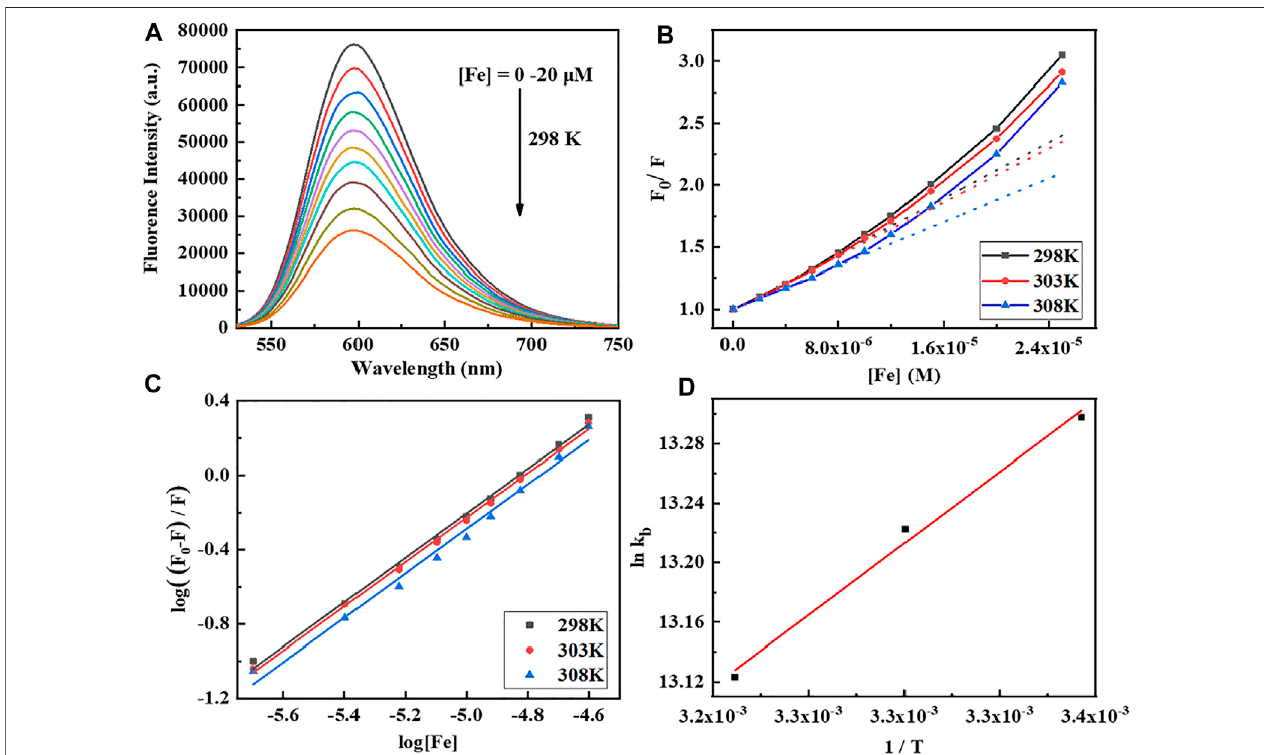
FIGURE 1 | (A) Fluorescence emission spectra of CT-DNA (170 μ M) titration with the Fe complex by increasing concentrations (0 – 20 μ M). The excitation wavelength is 520 nm at pH 7.4 and 298 K. (B,C) Stern – Volmer plot of CT-DNA quenched by the Fe complex at different temperatures. (D) Plot of ln K b vs. 1/T for the interaction of the Fe complex with CT-DNA.